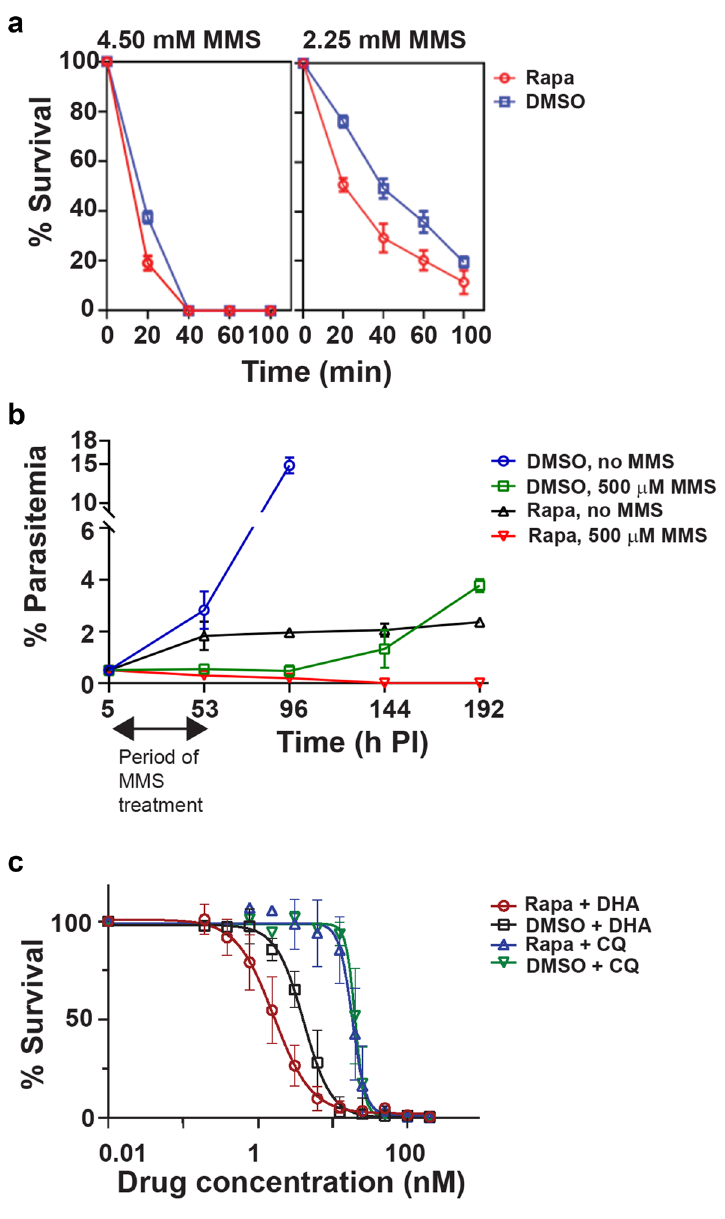
Figure 3. Deletion of Pfubc13 renders parasites more susceptible to the mutagen, methyl methanesulfonate (MMS) and dihydroartemisinin (DHA), but not chloroquine (CQ). ( a ) Synchronised parasite populations (5 to 8 h post invasion [PI], 1% parasitemia and 3% hematocrit) were pre-treated with DMSO (control) or rapamycin to induce ubc13 excision for 24 h, and then treated with 2.25 mM or 4.5 mM MMS for 0, 20, 40, 60 and 100 min. Parasite survival was assessed at 48 h. The data shown are mean ± SEM from duplicate experiments. ( b ) Long term survival of parasites treated with MMS. Synchronized parasite populations (5 h PI, 0.5% parasitemia and 3% hematocrit) were treated with rapamycin or DMSO and with or without 500 µM MMS. The cells were then washed to remove the drugs 48 h after the start of the experiment and the incubation was continued in complete medium. Giemsa-stained thin blood smears were examined at the time points indicated to determine percentage parasitemia. The data shown are mean ± SEM from triplicate experiments. ( c ) Parasites were treated with rapamycin or DMSO and increasing concentrations of either DHA or CQ. The percentage parasite survival was measured, allowing the EC 50 of the drugs in each condition to be calculated. The data shown are mean ± SEM from triplicate experiments The DHA EC 50 was 1.69 nM (95% CI: 1.41 to 1.99) and 4.1 nM (95% CI: 3.63 to 4.63) for the rapamycin and DMSO treated parasites, respectively, which is significantly different (P < 0.005, t-test), whereas there was no significant difference in the CQ EC 50 (18.51 [95% CI: 16.05 to 20.20] and 20.19 [95% CI: 18.53 to 21.48]) for the two